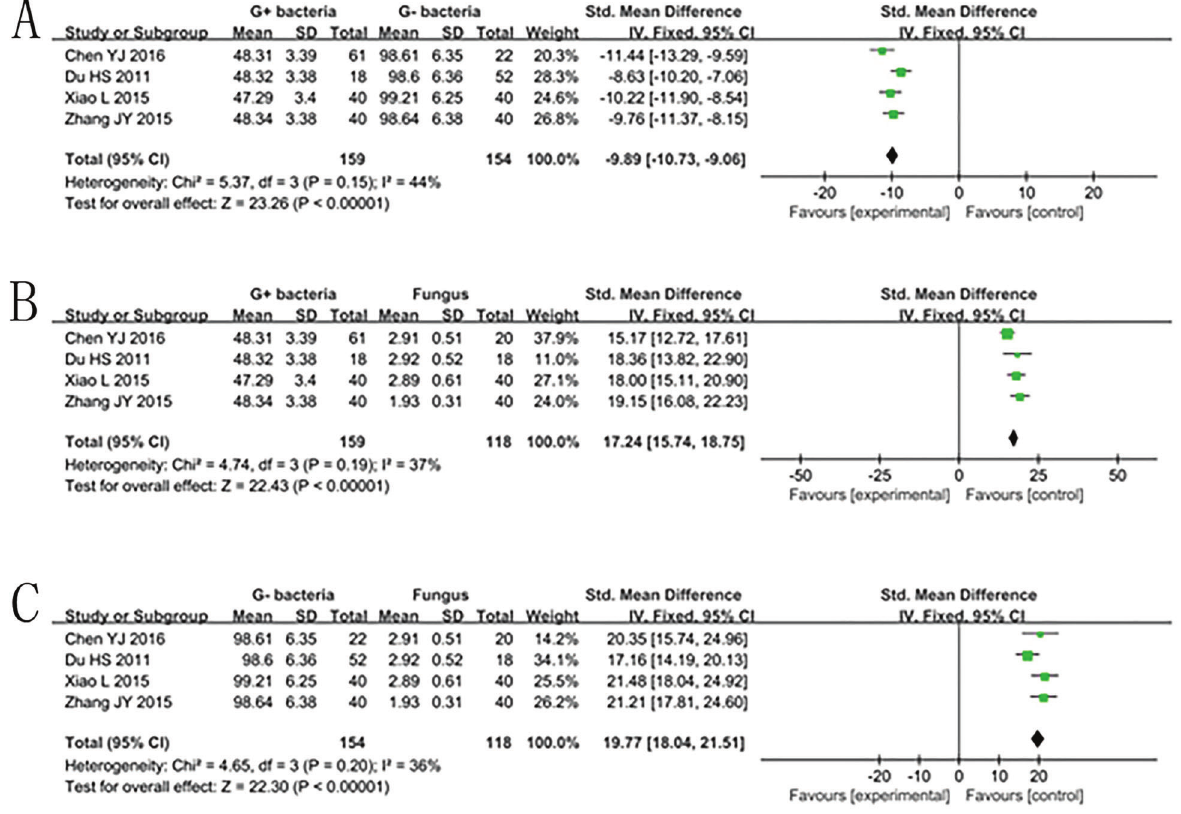
Figure 6. Forest plot for the concentration of CRP between A ) G + bacterial infection and G – bacterial infection group, B ) G + bacterial infection and fungus infection group, and C ) G – bacterial infection and fungus infection